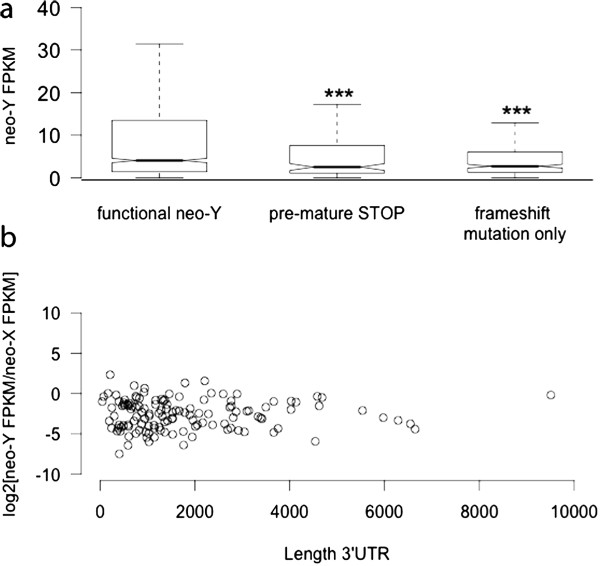
No evidence for nonsense-mediated decay in reducing neo-Y transcript abundance. (a) Neo-Y FPKM levels for transcripts with intact ORFs, transcripts containing a PTC and transcripts containing a frame-shift mutation only (and no PTC). Transcript levels for both classes of putative non-functional genes were significantly decreased, compared to those with intact ORFs (Wilcoxon test: W = 132628, p < 0.001 and W = 234562, p < 0.001). (b) Transcript abundance of the neo-Y in males, relative to the neo-X homolog in females, as a function of the length of the 3'UTR (estimated as the sum of the corresponding neo-X UTR length, plus the distance from the first PTC to the end of the CDS).